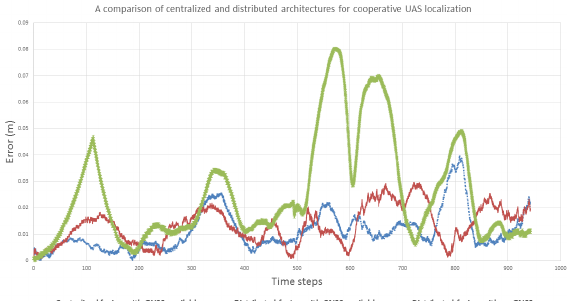
Figure 5: Error plots for all the nodes in the network assuming fully connected work and full GNSS availability.